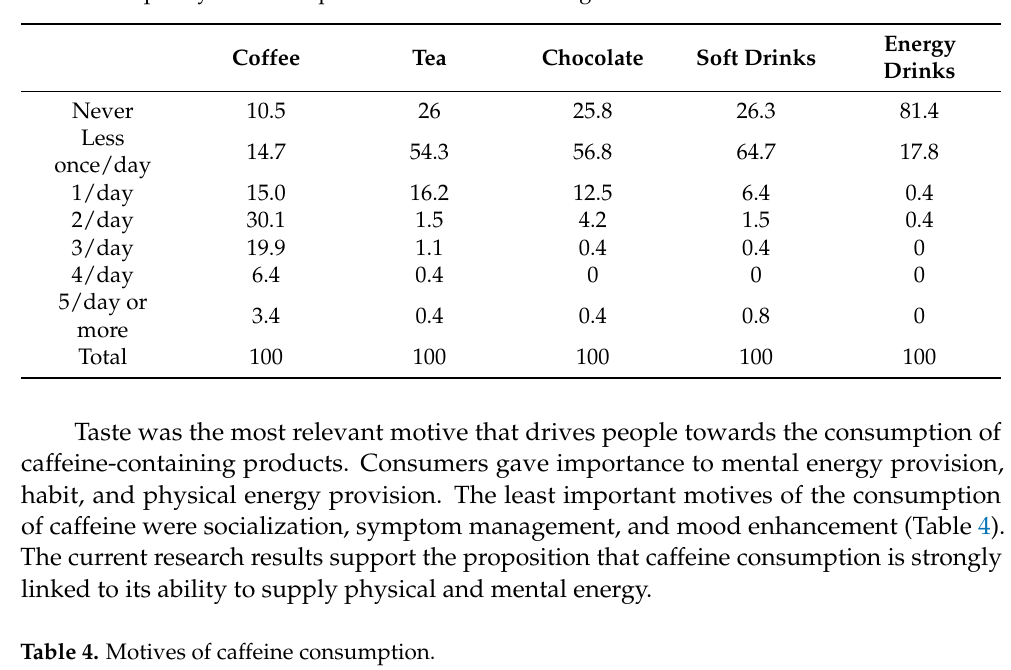
Table 3. Frequency of consumption of caffeine-containing traditional food and drinks.